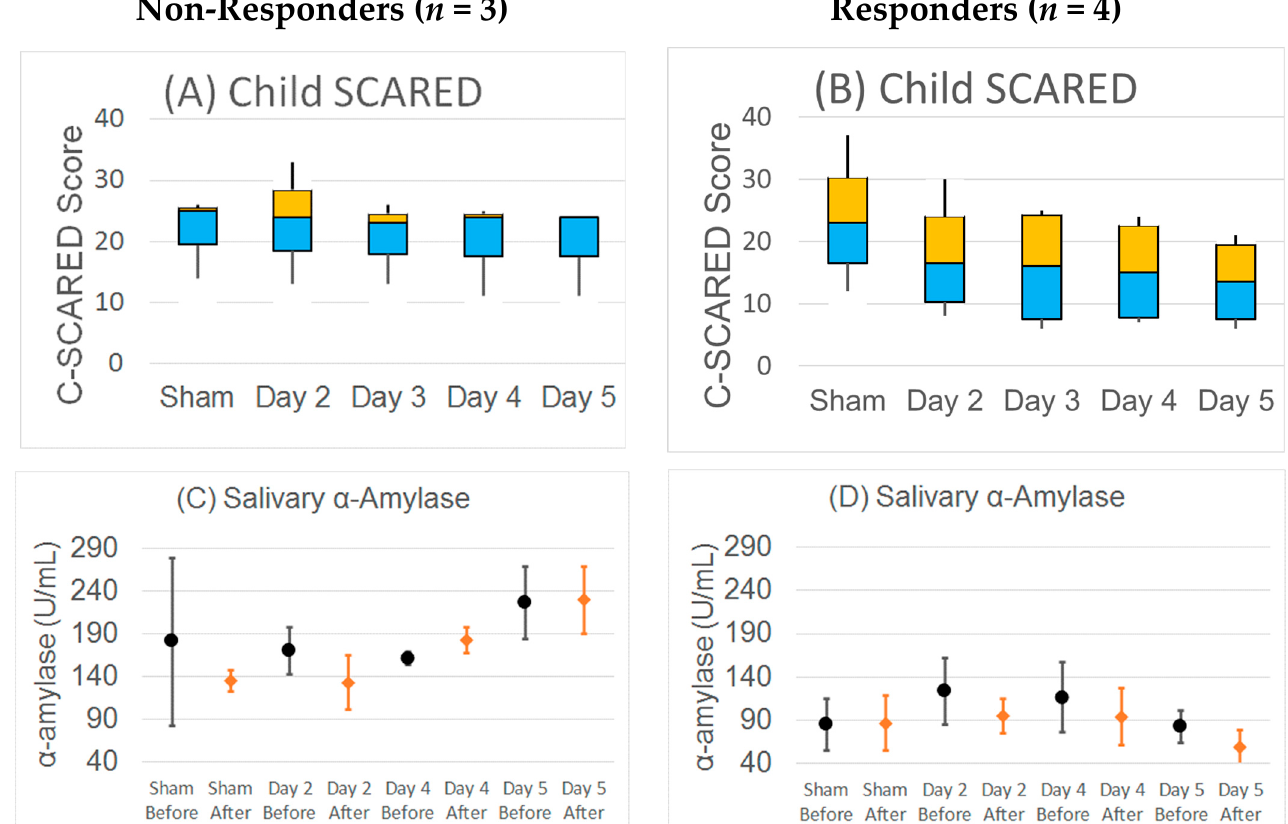
Figure 7. Responder analysis. Responders were defined as participants with an average of ≥ 30% improvement in the child-rated SCARED with treatment compared to the sham. In non-responders, the ( A ) child-rated SCARED did not change over sessions and ( C ) salivary α -amylase increased with more TEN sessions. In contrast, in responders the ( B ) child-rated SCARED markedly decreased and ( D ) α -amylase not only decreased with more TEN stimulation across multiple sessions, but also decreased from the beginning of the session to the end of the session on days the participants received TEN. For the child-rated SCARED median, quartiles and min and max are shown. For salivary α -amylase mean and standard error bars are